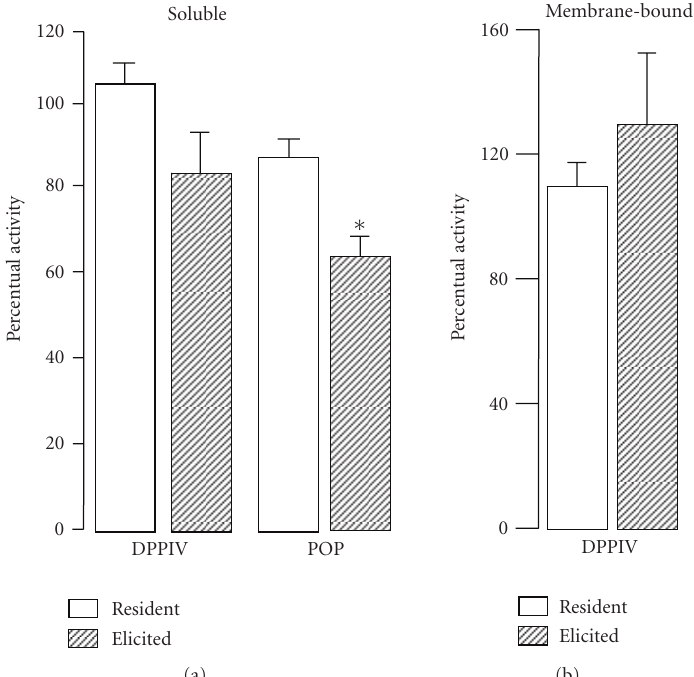
Figure 4: Percentual activity of soluble and membrane-bound dipeptidyl peptidase IV (DPPIV) and prolyl oligopeptidase (POP) activities in resident and thioglycollate-elicited murine macrophages from cyclosporine-treated in relation to the respective control (100%). Values are means ± SEM from 5 animals (assays made in triplicate). ∗ P < . 05 in comparison to control (unpaired two-sided Student’s t -test).